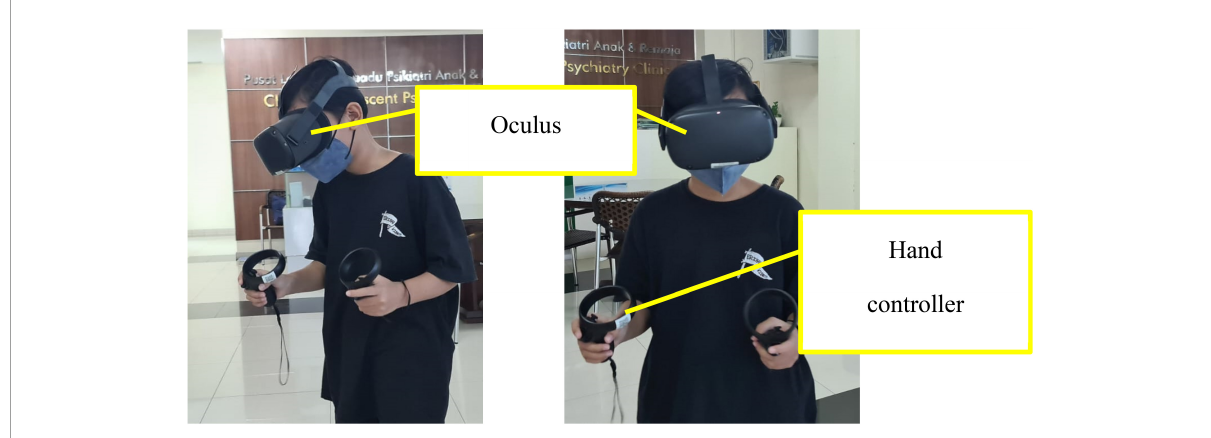
FIGURE3 Attention deficits/hyperactivity disorder-virtual reality diagnostic